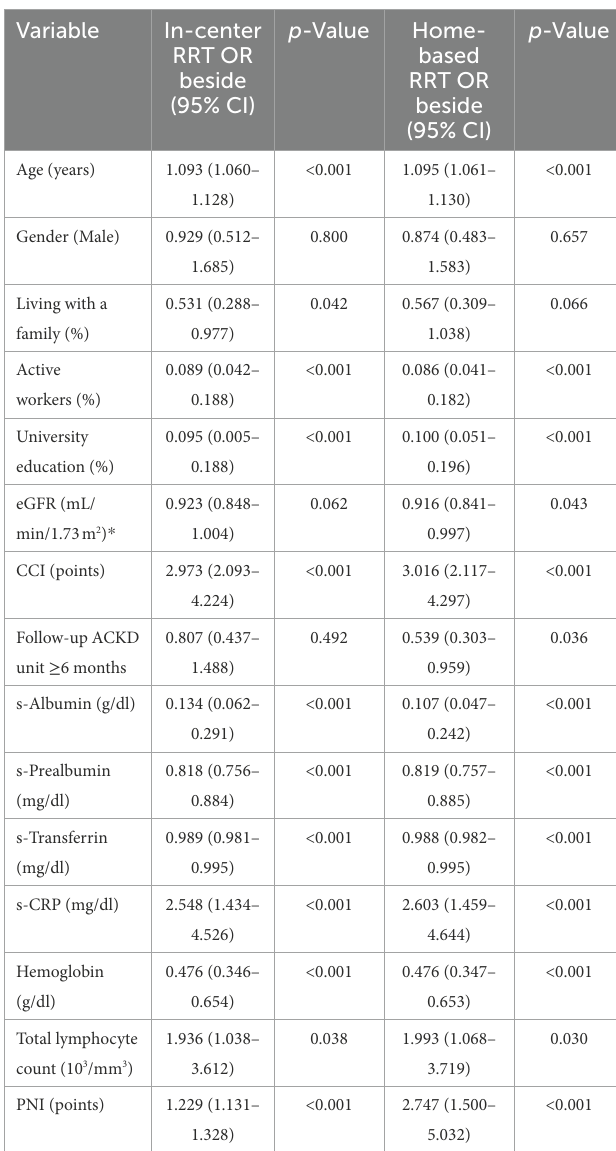
TABLE 4 Univariate binary regression analysis of factors associated with the decision-making to choose in-center or home-based renal replacement